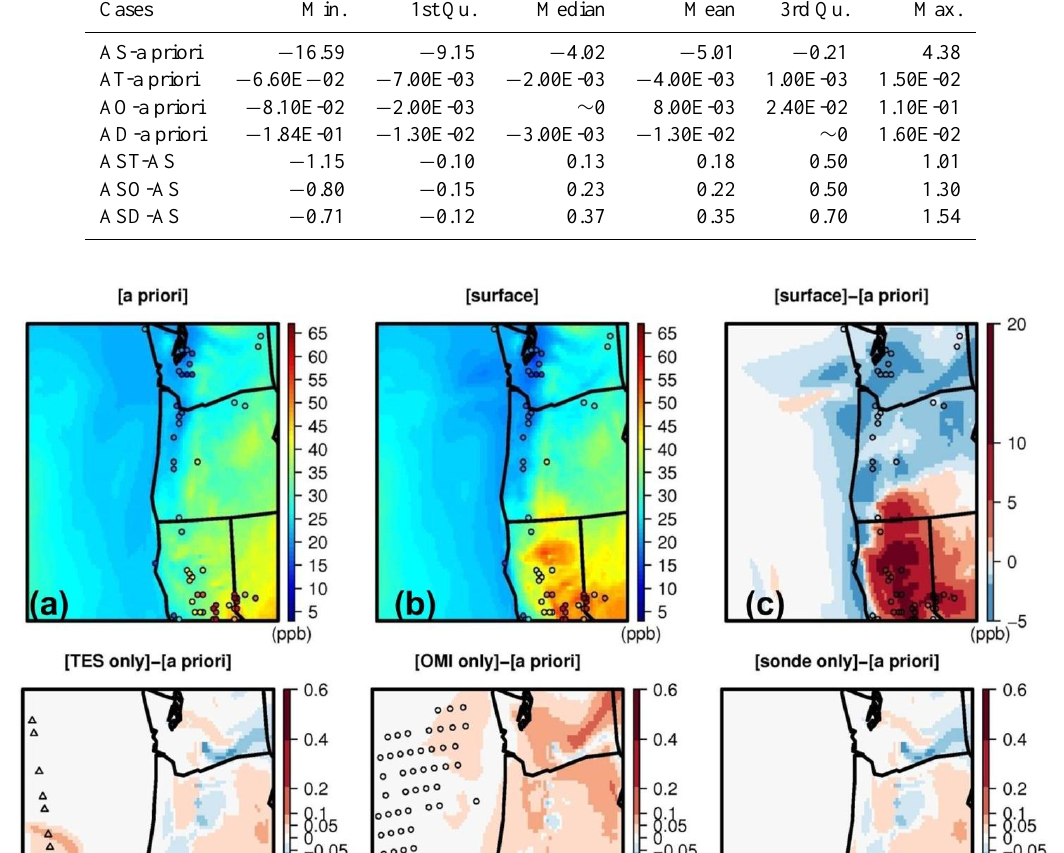
Table 6. Changes of daytime-mean surface O 3 errors between different cases, where error= | modeled-observed | . Cases